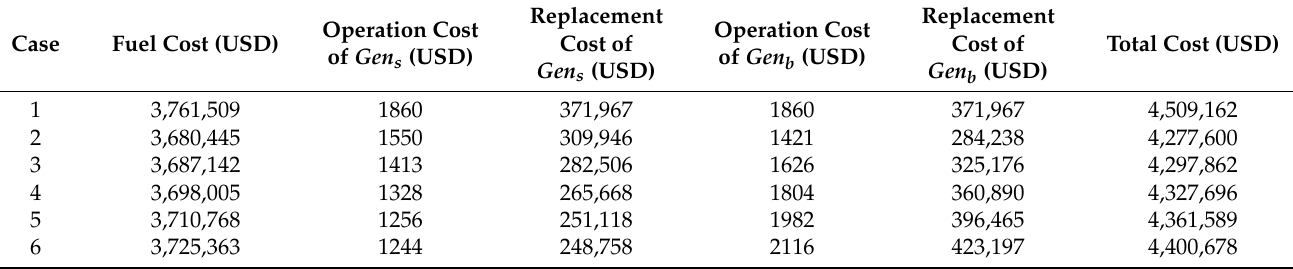
Table 8. Total cost in each